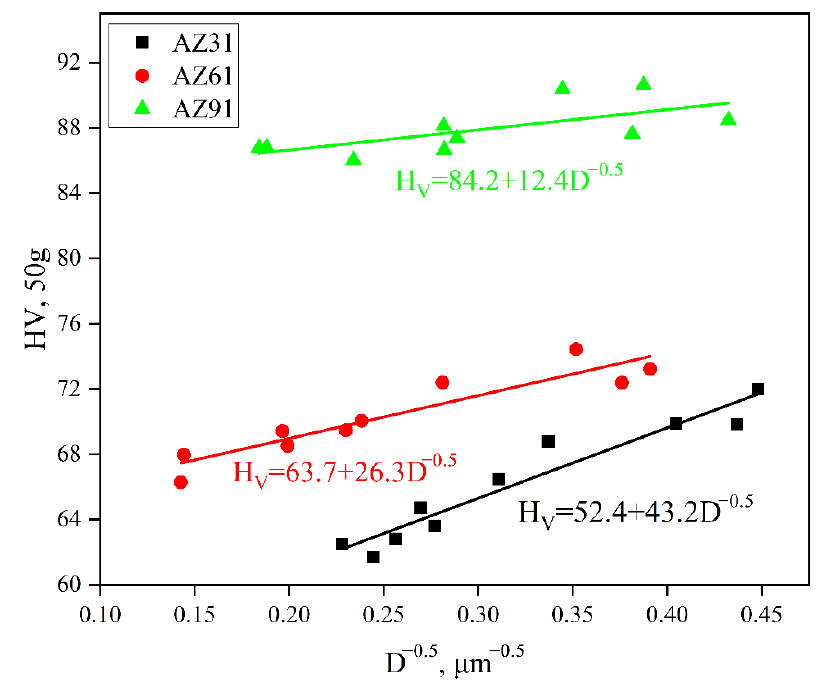
Figure 20. The Microhardness of Mg–xAl–1Zn (x = 3, 6, 9) alloys as a function of Al content and grain size.